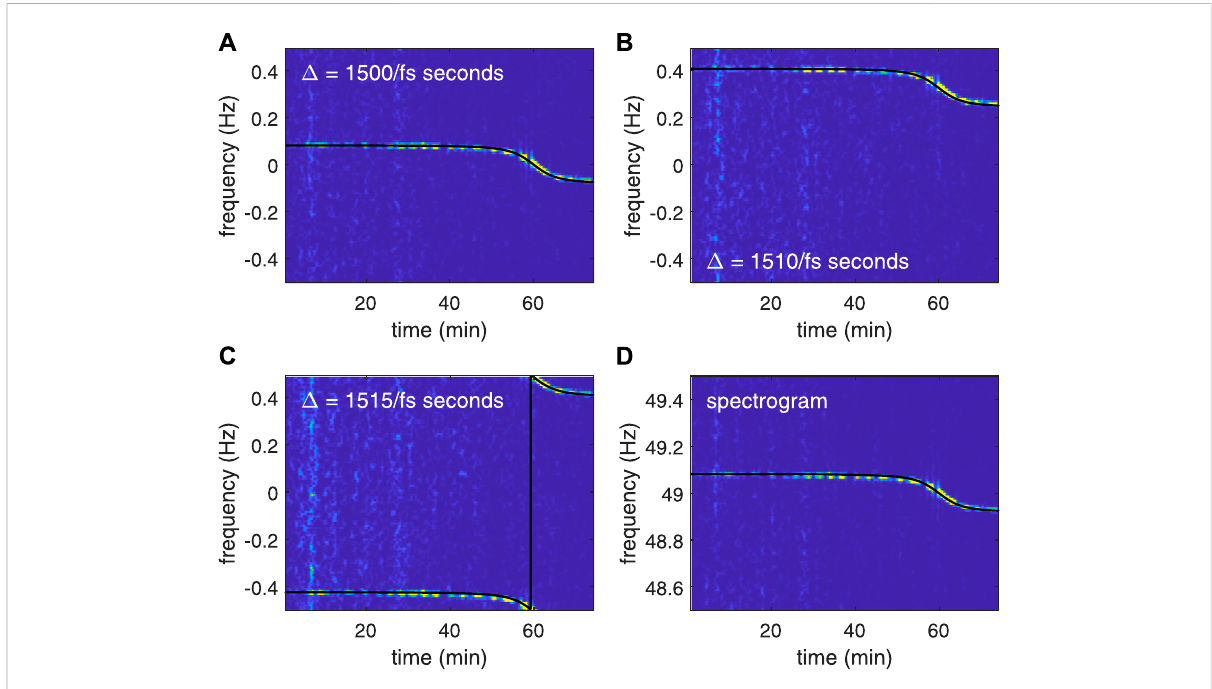
FIGURE 1 The SWellEx-96 signal used in Section 4 is employed to illustrate the phenomenon of Doppler shift offset. The sampling rate of the signal is f s = 1,500 Hz. (A – C) illustrate, respectively, the TFDs produced by the conventional cross-spectrum method (i.e., the step R2.3 of F-STFT without compensation) with different lengths of the spectral window N w 1 = [1,500, 1,510, 1,515] in sound pressures extraction. Black curves represent the IF curves of each TFD predicted by the bandpass sampling theorem. Frequency axes of these TFDs represent oscillation frequency f 0 v r c . For a comparison, (D) shows the TFD produced by STFT and the theoretical IF curve given by Eq. A7. It can be seen that a slight increase of N w 1 brings a signi fi cant offset for the aliased IF